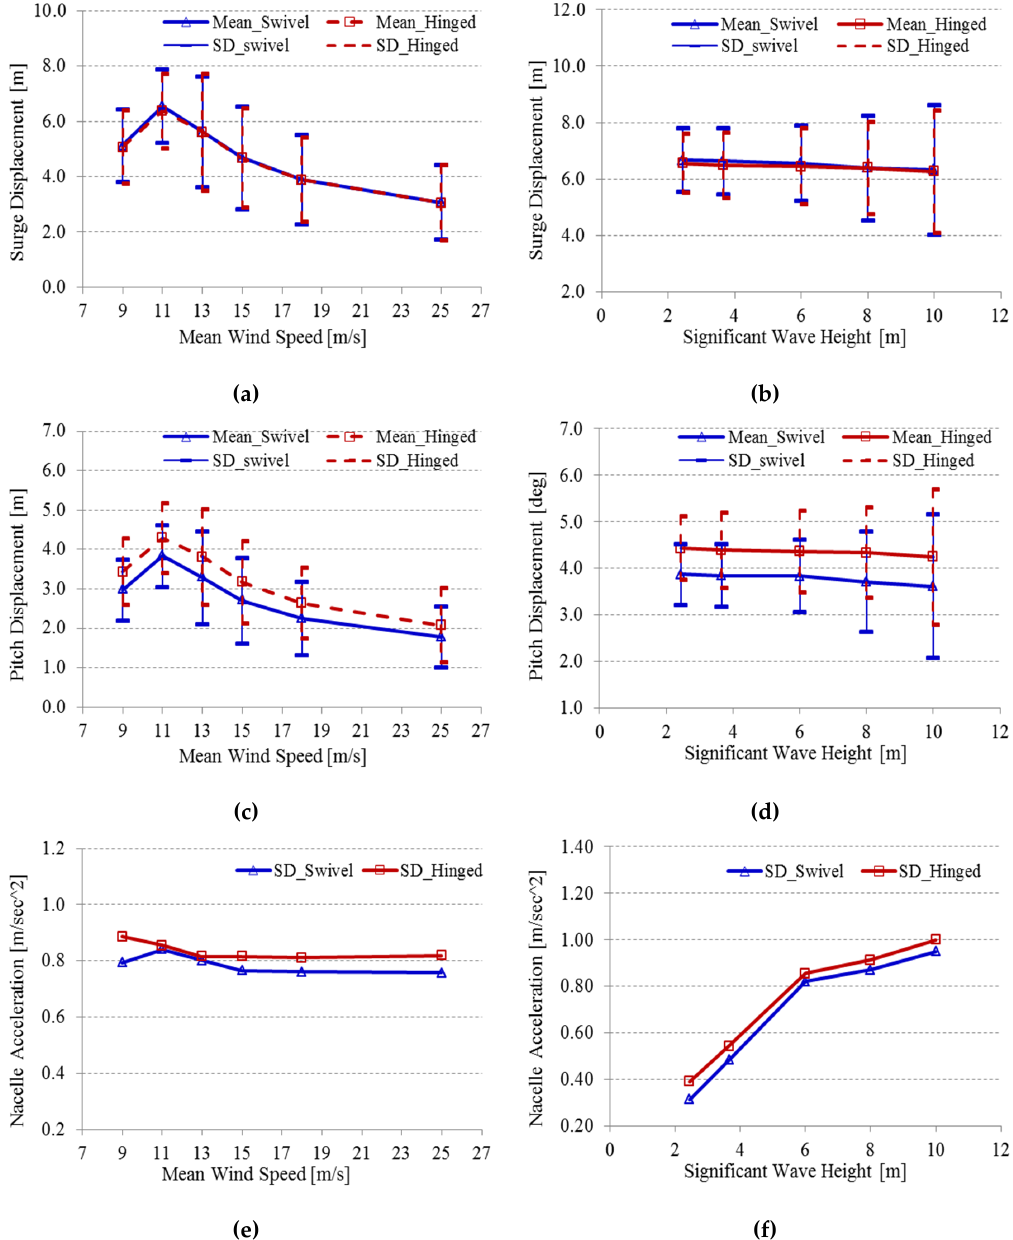
Figure 16. Surge/pitch motions and turbine performance with 100m water depth: ( a ) Surge motion V.S. Wind speed. ( b ) Surge motion V.S. Significant wave height. ( c ) Pitch motion V.S. Wind speed. ( d ) Pitch motion V.S. Significant wave height. ( e ) Nacelle acceleration V.S. Wind speed. ( f ) Nacelle acceleration V.S. Significant wave height. SD: standard deviation.